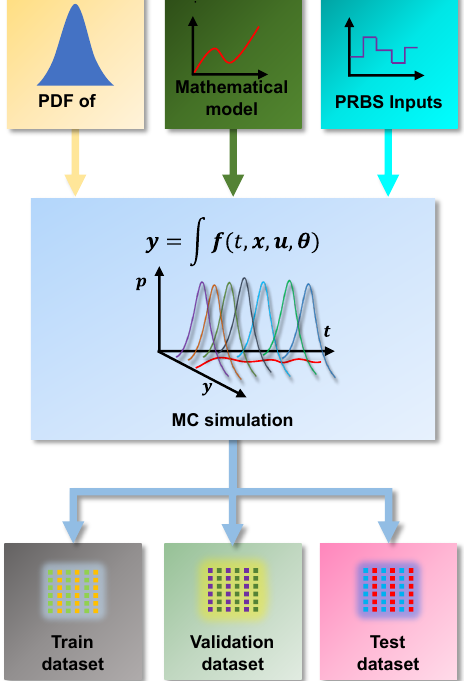
Figure 3. Monte Carlo simulation method for data